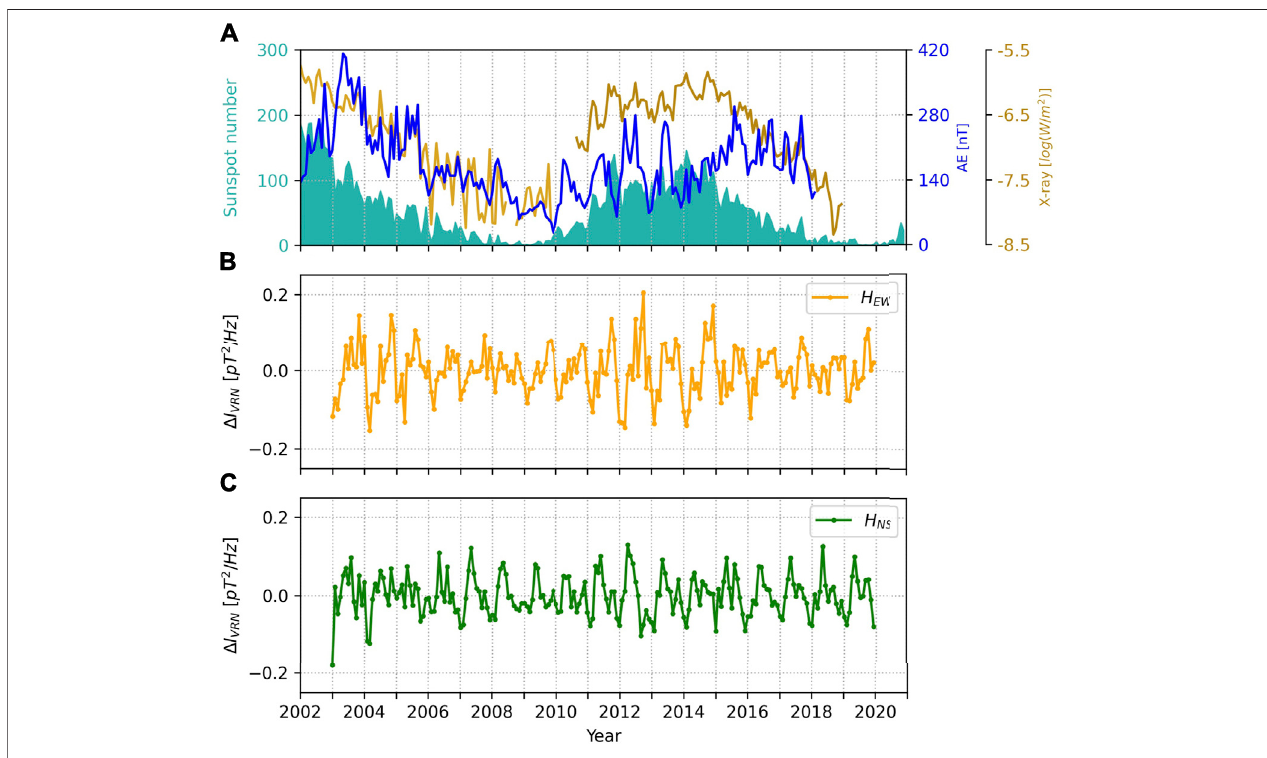
FIGURE 4 | (A) Monthly average values of the sunspot number (turquoise), the AE index (blue) and the X-ray fl ux (GOES-10: gold, GOES-15: dark gold) as well as the residual monthly average SR intensities for the (B) H EW and (C) H NS components at the Vernadsky (VRN) station (see the main text for more details).